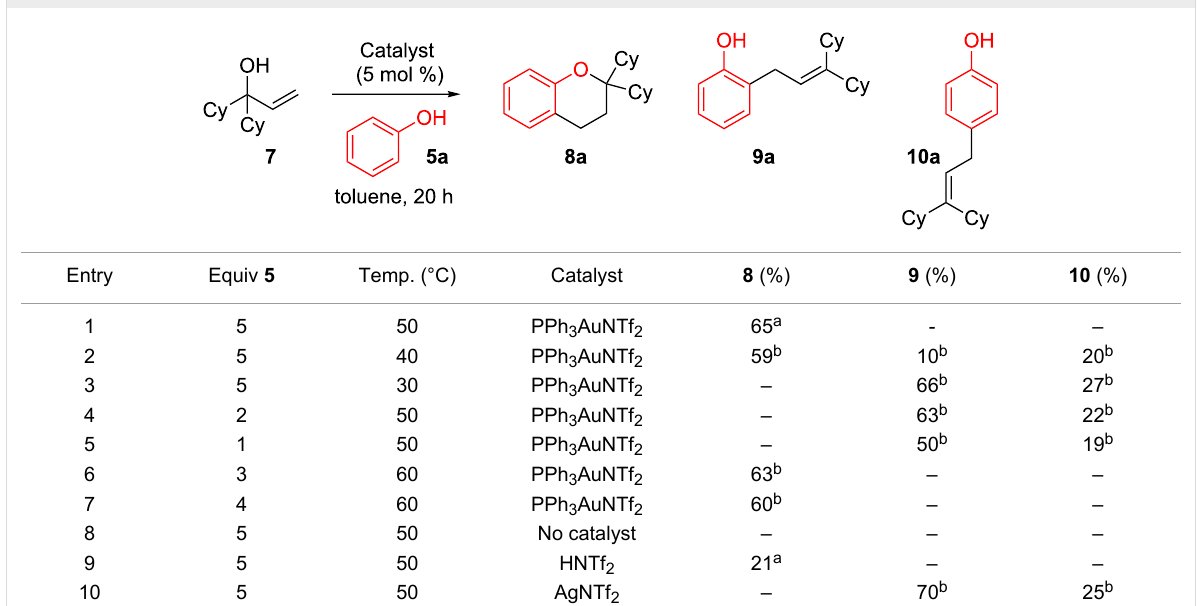
Table 1: Initial temperature and equivalents screens, and control